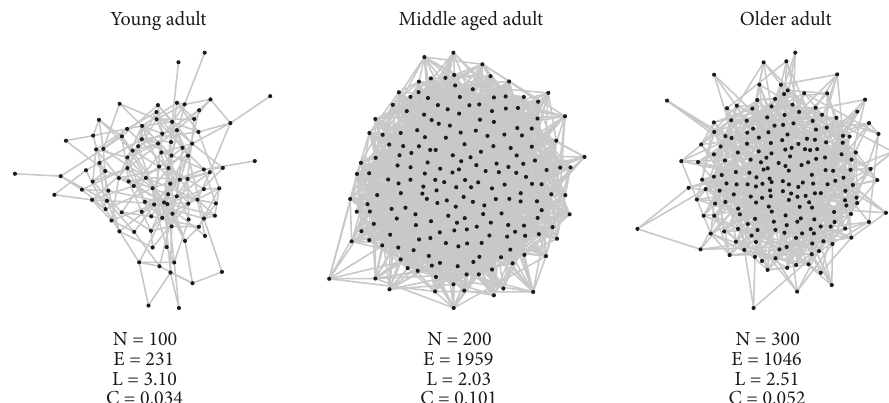
Figure 7: The structureof free association networks changes across the lifespan, with the youngest network on the left and the oldest network on the right. Over the lifespan, the network grows in size (i.e., the number of nodes, N , increases). The network is quite sparse in early life, becomes most densely connected early in adulthood, and becomes less connected in old age. Adapted from Dubossarsky, De Deyne, and Hills